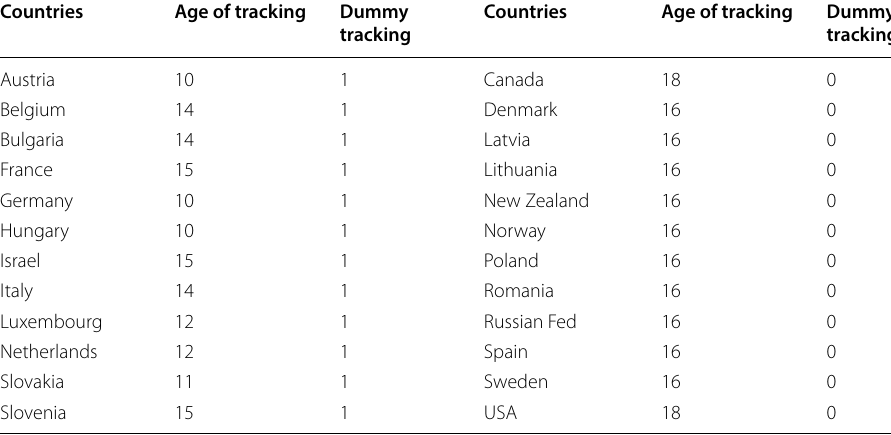
Source: see Appendix A, Table 5 Dummy tracking: